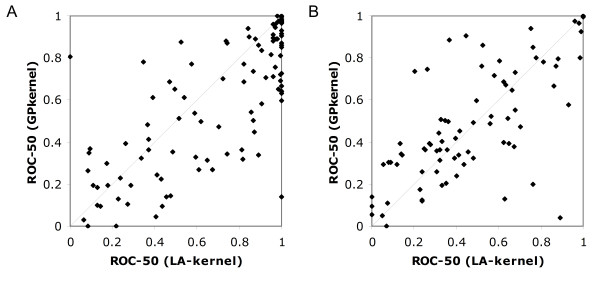
The GPkernel and LA-kernel predictions are complementary. The graphs show the LA-kernel's ROC-50 scores plotted against those of the GPkernel on the superfamily (A) and fold (B) benchmarks. Identical predictions from the two methods would fall on the diagonal line.